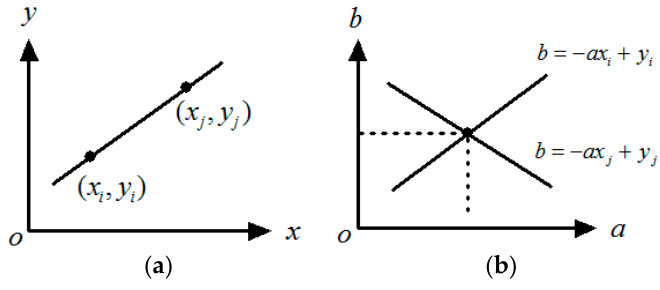
Figure 2. Points and lines in ( a ) image space and ( b ) parameter space.